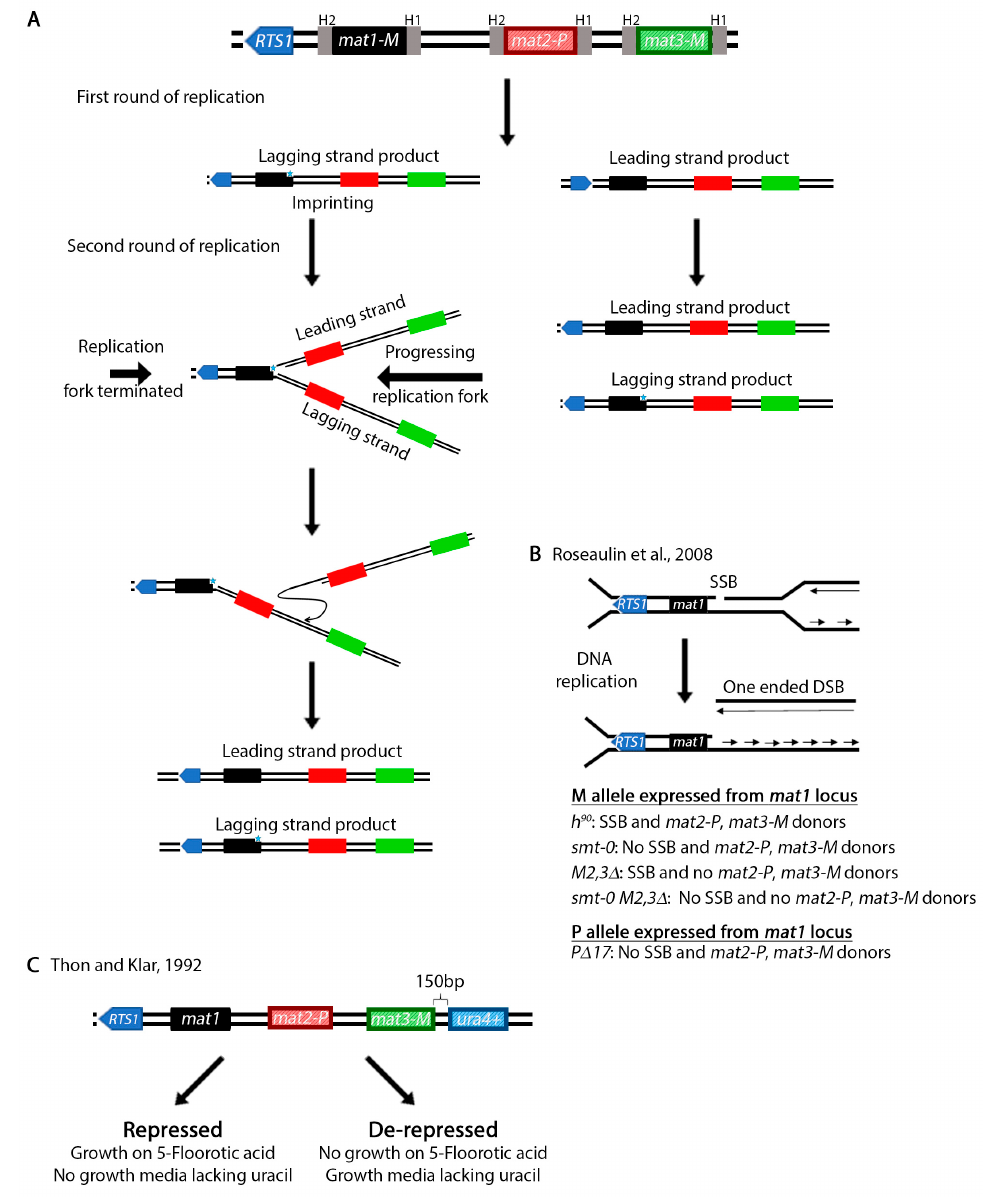
Figure 5. Mating type switching in S. pombe . ( A ) Diagram of the process of mating type switching. The mating type region has three cassettes mat1 , mat2-P(plus) and mat3-M(minus). Only mat1 is expressed with either P or M while mat2-P and mat3-M are silenced. The shading of mat2-P and mat3-M diagrams represents this silencing. Information switches from mat2-P and mat3-M onto mat1 so that mat1 expresses either P or M. All three cassettes are flanked by homologous regions (H1, H2) that facilitate recombination. In this diagram, we begin with a hypothetical example where mat1 expresses the M information. After one round of replication, an imprint consisting of insertion of one or two ribonucleotides or a single strand nick is made next to the mat1-M cassette on the lagging strand (blue star). For simplicity, the top diagram does not have the imprint. In the second round of replication, the leading strand collides with the imprint and produces a blunt one-ended DSB. To ensure that only the leading strand passes through the imprint, the replication fork from the other direction is paused and terminated by the RTS1 site. The one-ended break is repaired by copying information from the mat2-P or mat3-M regions. Since in our example the M information was expressed at mat1 , the break may be repaired using mat2-P and the information at mat1 switches. Note that the imprint is always placed on the lagging strand with each DNA replication. ( B ) Exploiting the mating type loci to study rescue of collapsed forks. Collision of the leading strand with the imprint produces a blunt one-ended